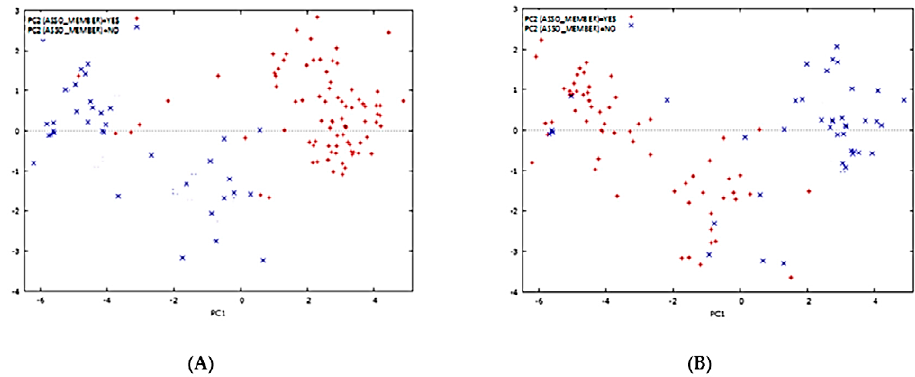
Figure 6. (A) Scatter plot of Arriba producers and associativity; (B) Scatter plot of CCN-51 producers and